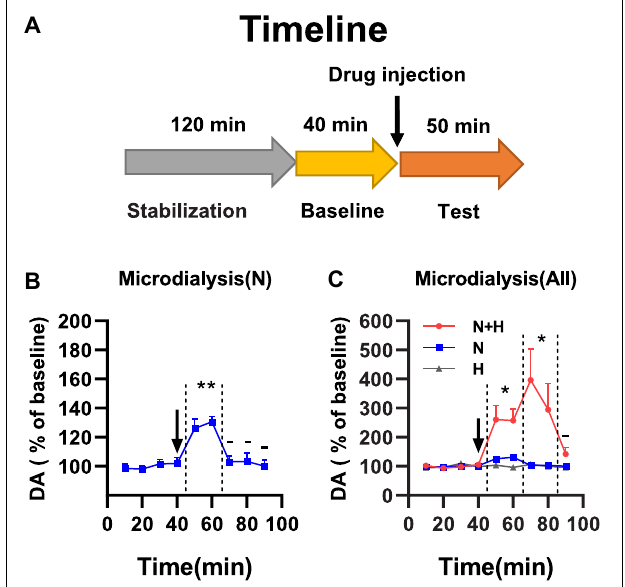
FIGURE 4 | (A) Timeline of microdialysis study. (B) Effects of nicotine alone on dopamine release in nucleus accumbens. Significant dopamine release was showed in N group within 20 min of drug injection (** p < 0.01). (C) Effects of harmane and nicotine on dopamine release in nucleus accumbens. N + H group showed significantly increased release of dopamine compared to N group (* p < 0.05) in the first 20 min, and maintained high levels of extracellular dopamine in 40 min after injection compared to N group (* p < 0.05). Data are presented in the figure using mean ± SEM.